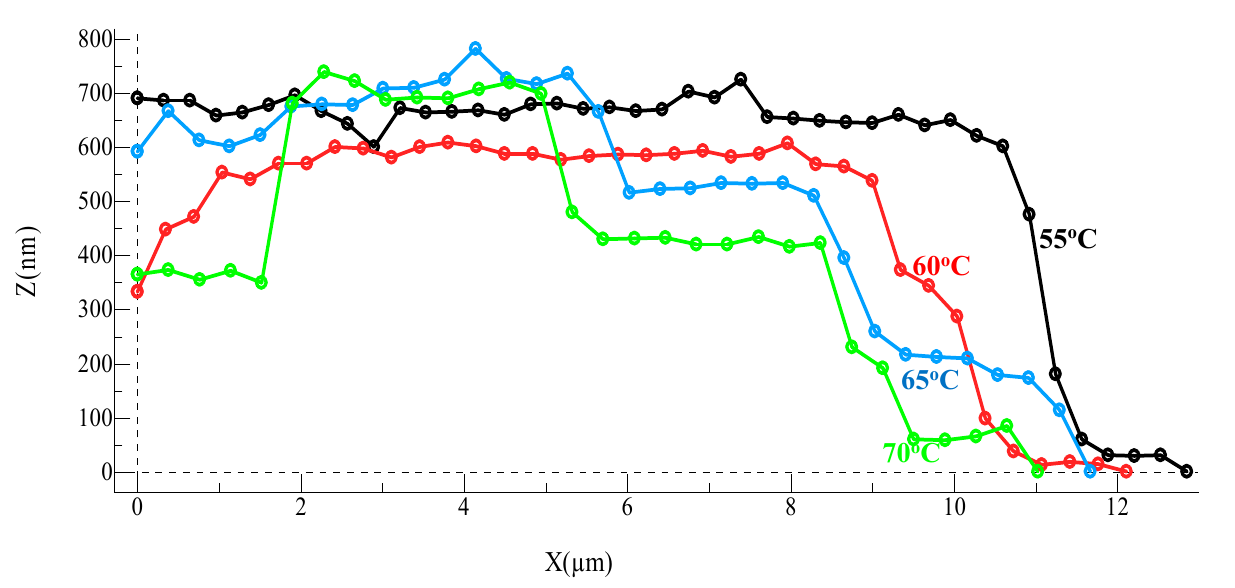
Figure 2. Profiles of island heights upon heating at different temperatures showing negligible decrease in height and the appearance of new crystal steps upon heating.